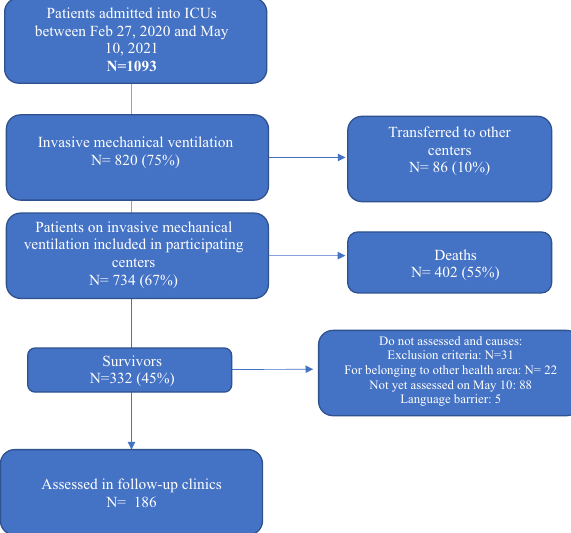
Figure 1. Flowchart showing the patients included into the